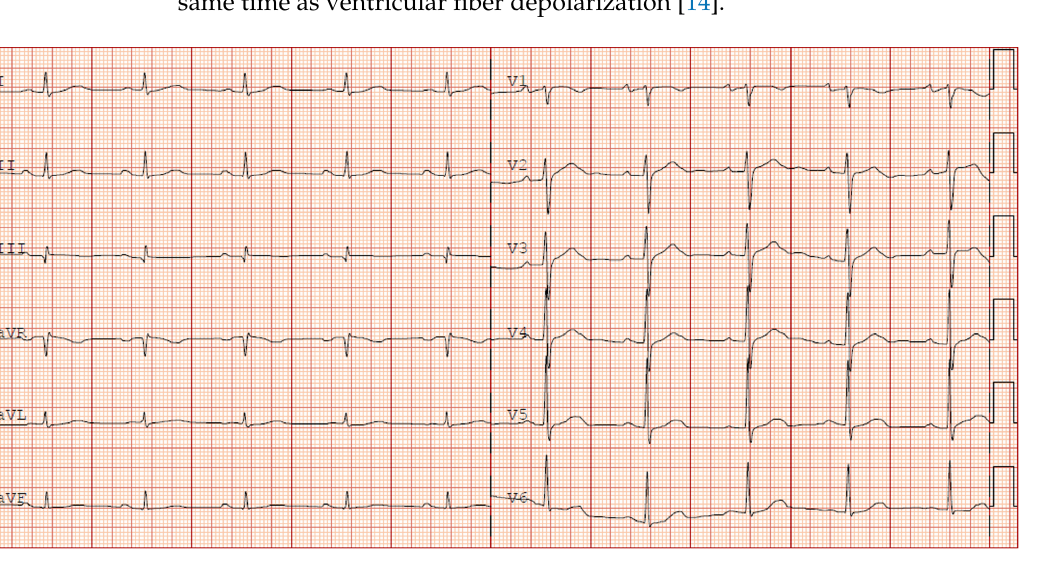
Figure 2. A standard 12-lead ECG of a single patient [15].